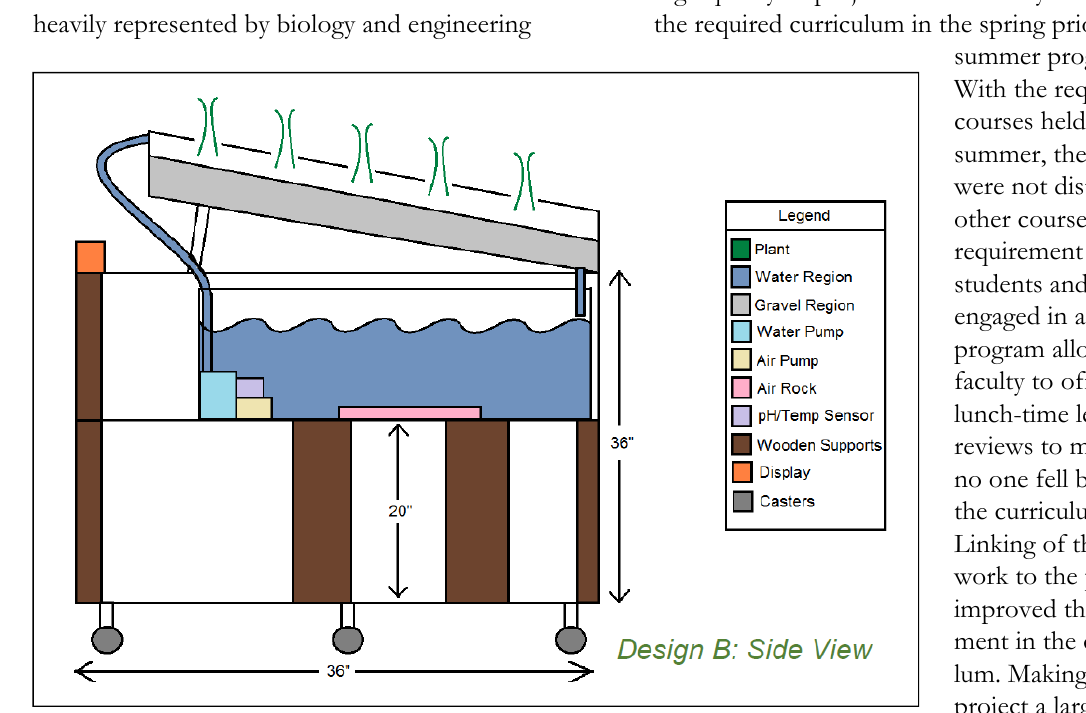
Figure 2. Sample Schematic of Student-designed System that Will Support Fish and Hydroponic Plant